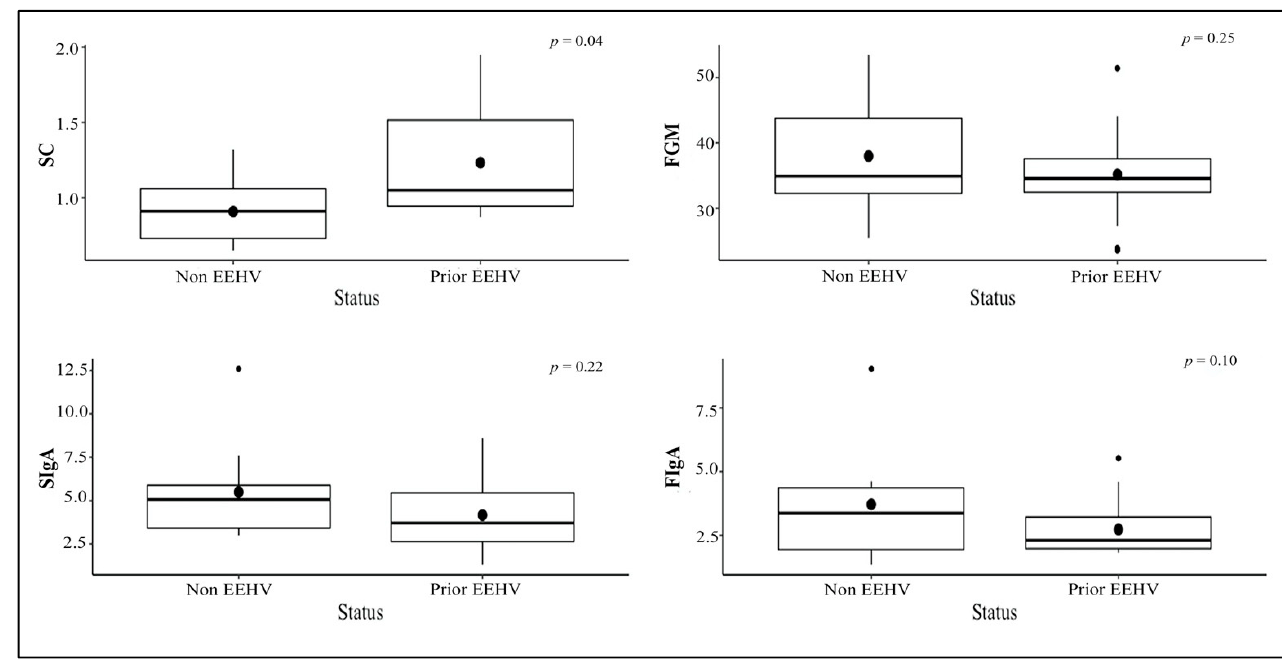
Figure 4. Boxplot presented concentrations of salivary cortisol (SC), fecal glucocorticoid metabolites (FGM), salivary IgA (SIgA), and fecal IgA (FIgA) categorized by season.